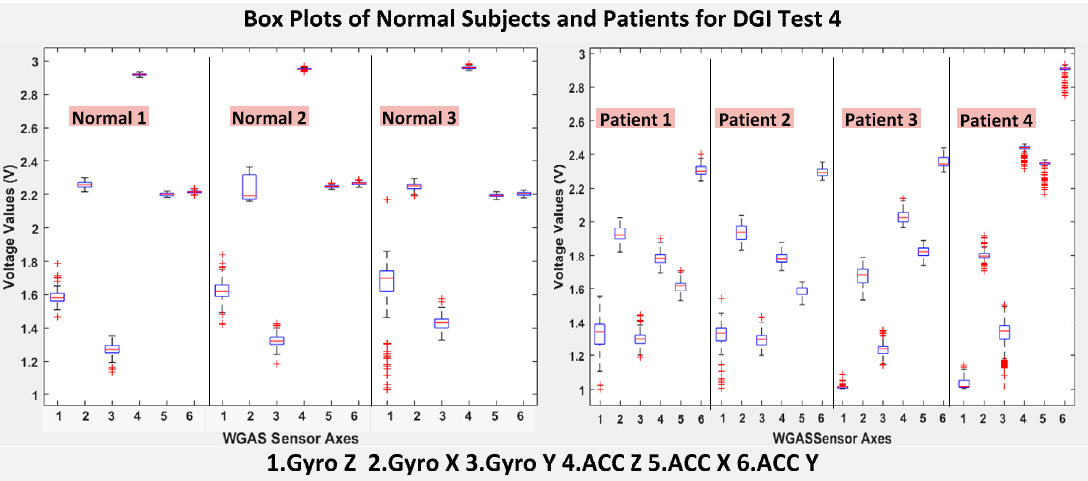
Figure 6. Box plots of DGI Test 4: Data for normal subjects (left) vs. patients (right).